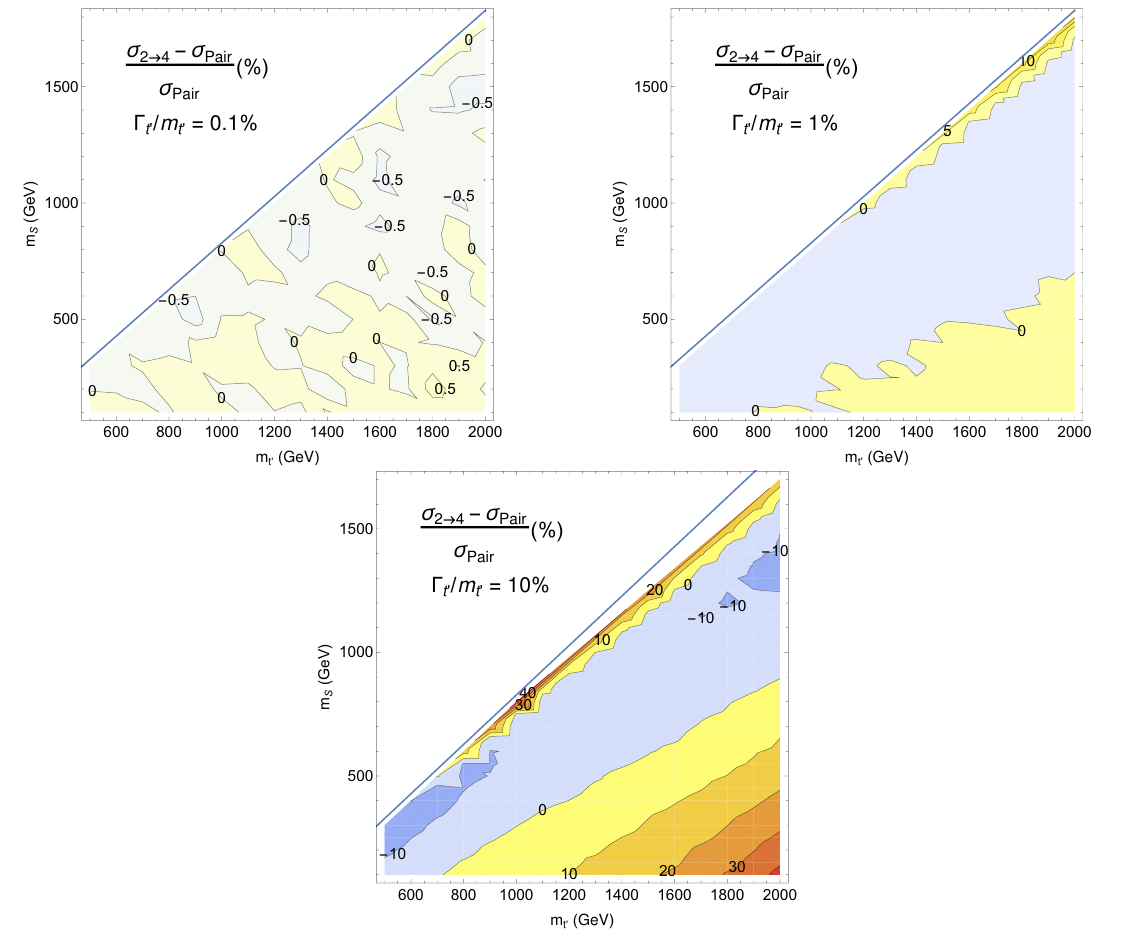
Figure 17 . Relative ratio of the cross-sections for the full process pp ! t (cid:22) tSS ( (cid:27) 2 pair production process pp ! t 0 (cid:22) t 0 ! ( S t )( S (cid:22) t ) where the t 0 production and decay are factorised